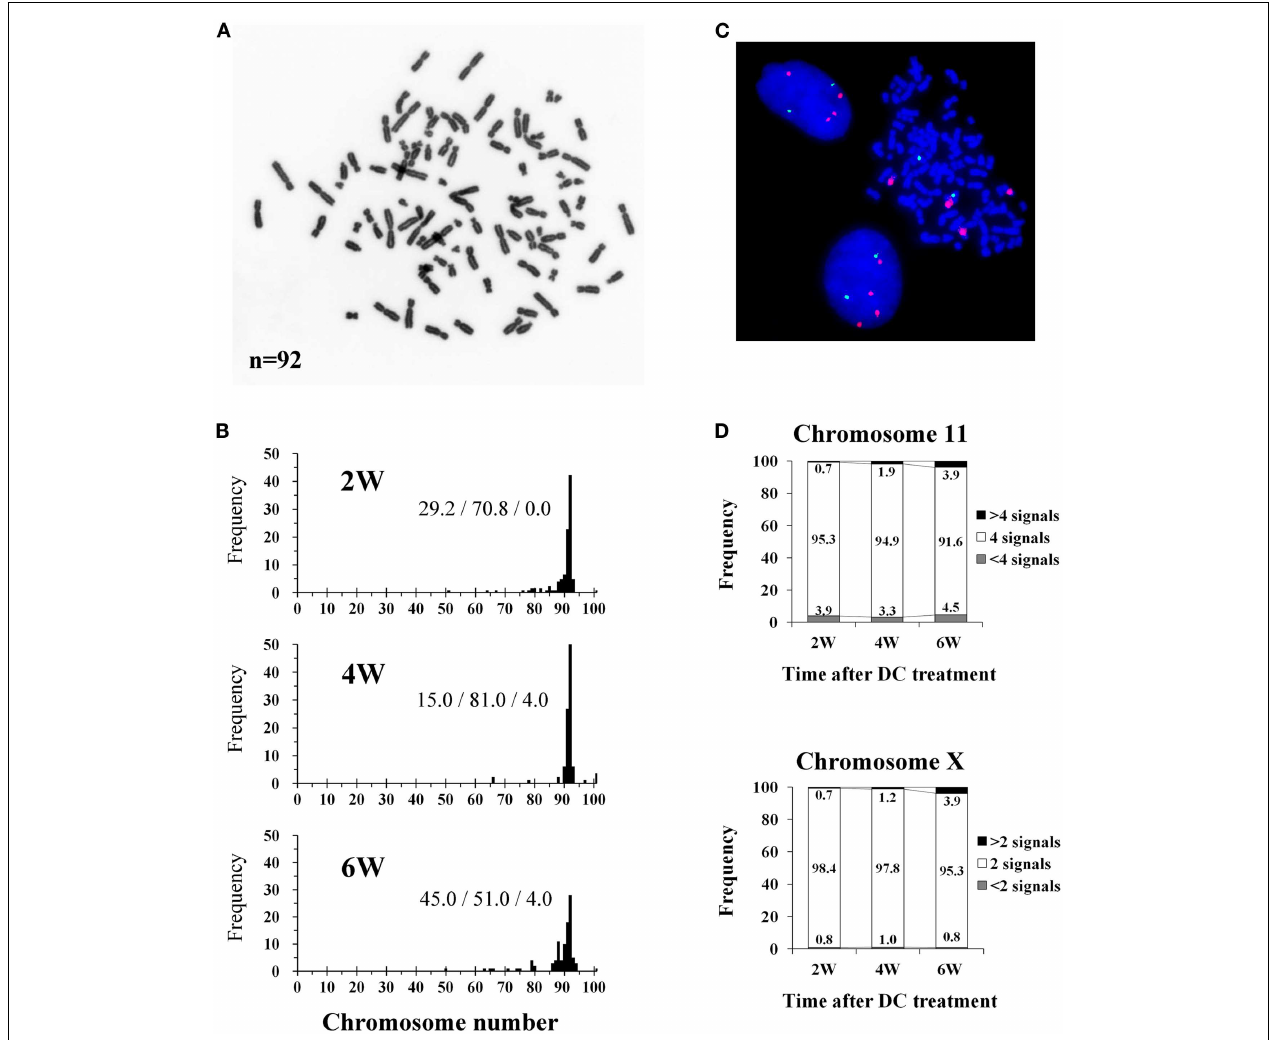
tetraploid cells prepared at 16days after DC treatment. Orange signals represent chromosome 11, and green signals represent chromosome X.Two interphase cells and one mitotic cell show tetrasomy for chromosome 11 and disomy for chromosome X, indicating that they are male tetraploid cells. (D) Frequencies of FISH signals for chromosome 11 and X scored at 2, 4, and 6weeks after DC treatment. Signals were scored for at least 1000 interphase cells per experiment. Numbers in the accumulated bar graphs represent frequencies of cells with the given number of